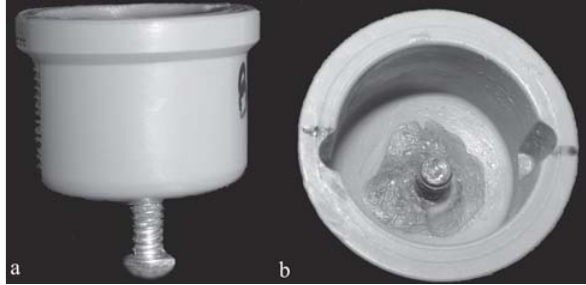
FIGURE 1- Frontal view of the PVC ring (a) and PVC with its base perforated (b)